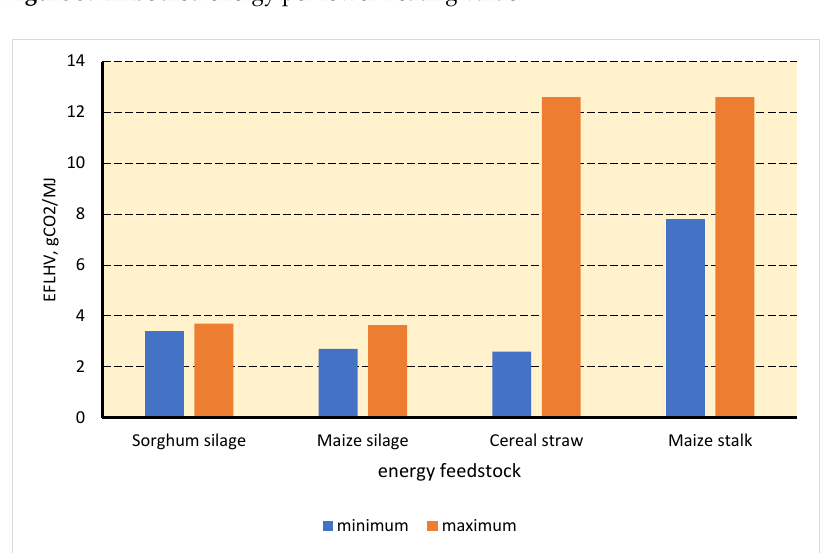
Figure 4. Emission factor per lower heating value.